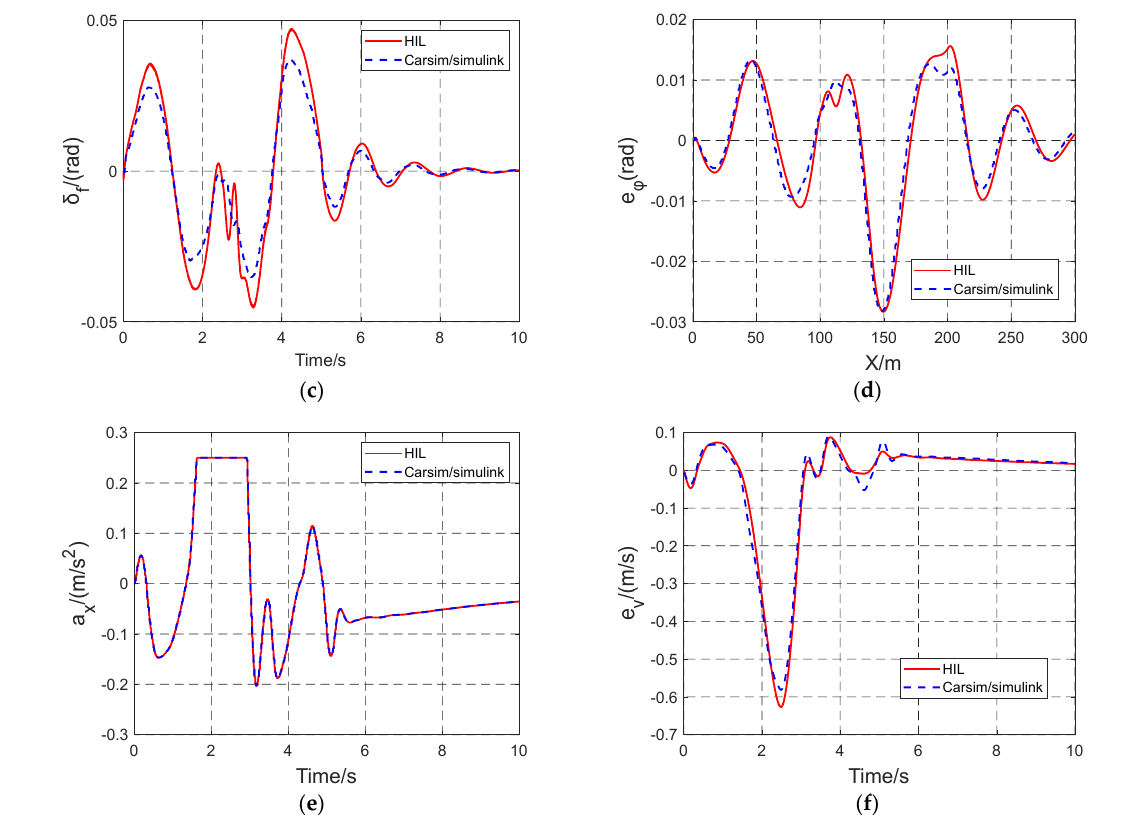
Figure 18. Trajectory tracking simulation results at Scenario D: ( a ) Driving paths; ( b ) Lateral error; ( c ) The front-wheel steering angle; ( d ) The heading error; ( e ) Longitudinal acceleration; ( f ) Longi- tudinal velocity error. Table 8. RMSE of trajectory tracking error in Scenario D. HIL